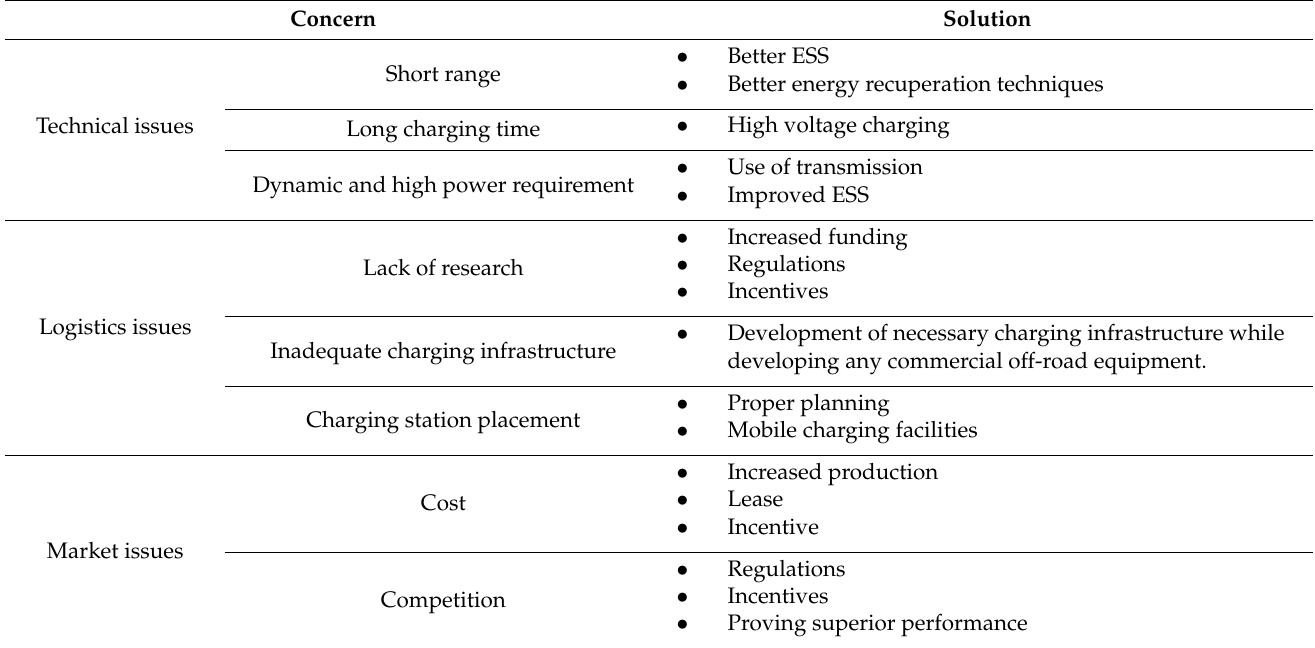
Table 9. Concerns surrounding off-road equipment electrification and potential